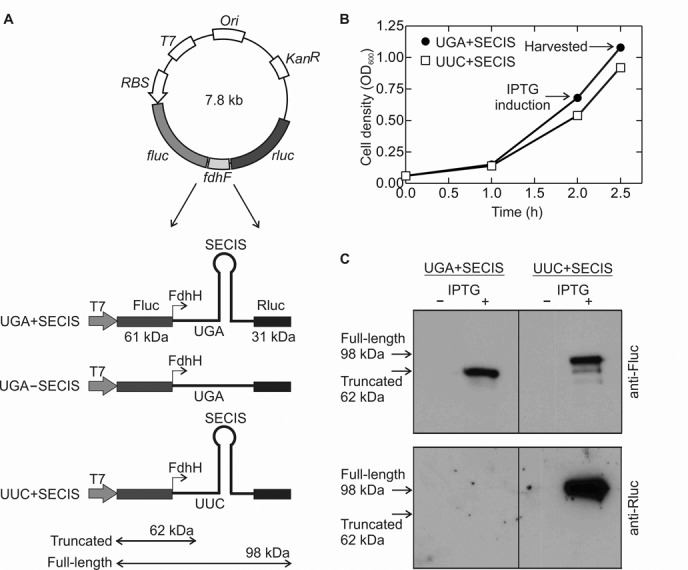
Experimental system to investigate UGA recoding by Sec. (A) Constructs for dual-luciferase reporter assay. A fragment of the fdhF gene was inserted between firefly (fluc) and renilla (rluc) luciferase genes. The fragment of the wild-type fdhF gene codes for amino acids 130–179 including a UGA codon at position 140 followed by the SECIS. Test constructs: recoding segment containing both the stop codon and the SECIS (UGA+SECIS), or without the SECIS element (UGA–SECIS), or with the UGA codon replaced with a UUC codon (coding for Phe) (UUC+SECIS). (B) Growth curves of E. coli Tuner (DE3) cells transformed with test constructs. Protein expression was induced by IPTG addition. Times of protein expression induction (initial-log phase) and harvest are indicated. (C) Expression of the Fluc–FdhF (62 kDa) and Fluc–FdhF–Rluc (98 kDa) proteins was visualized by western blot analysis using antibodies against Fluc (upper panel) or Rluc (lower panel). Fluc–FdhF–Rluc is synthesized as a result of UGA or UUC read-through.